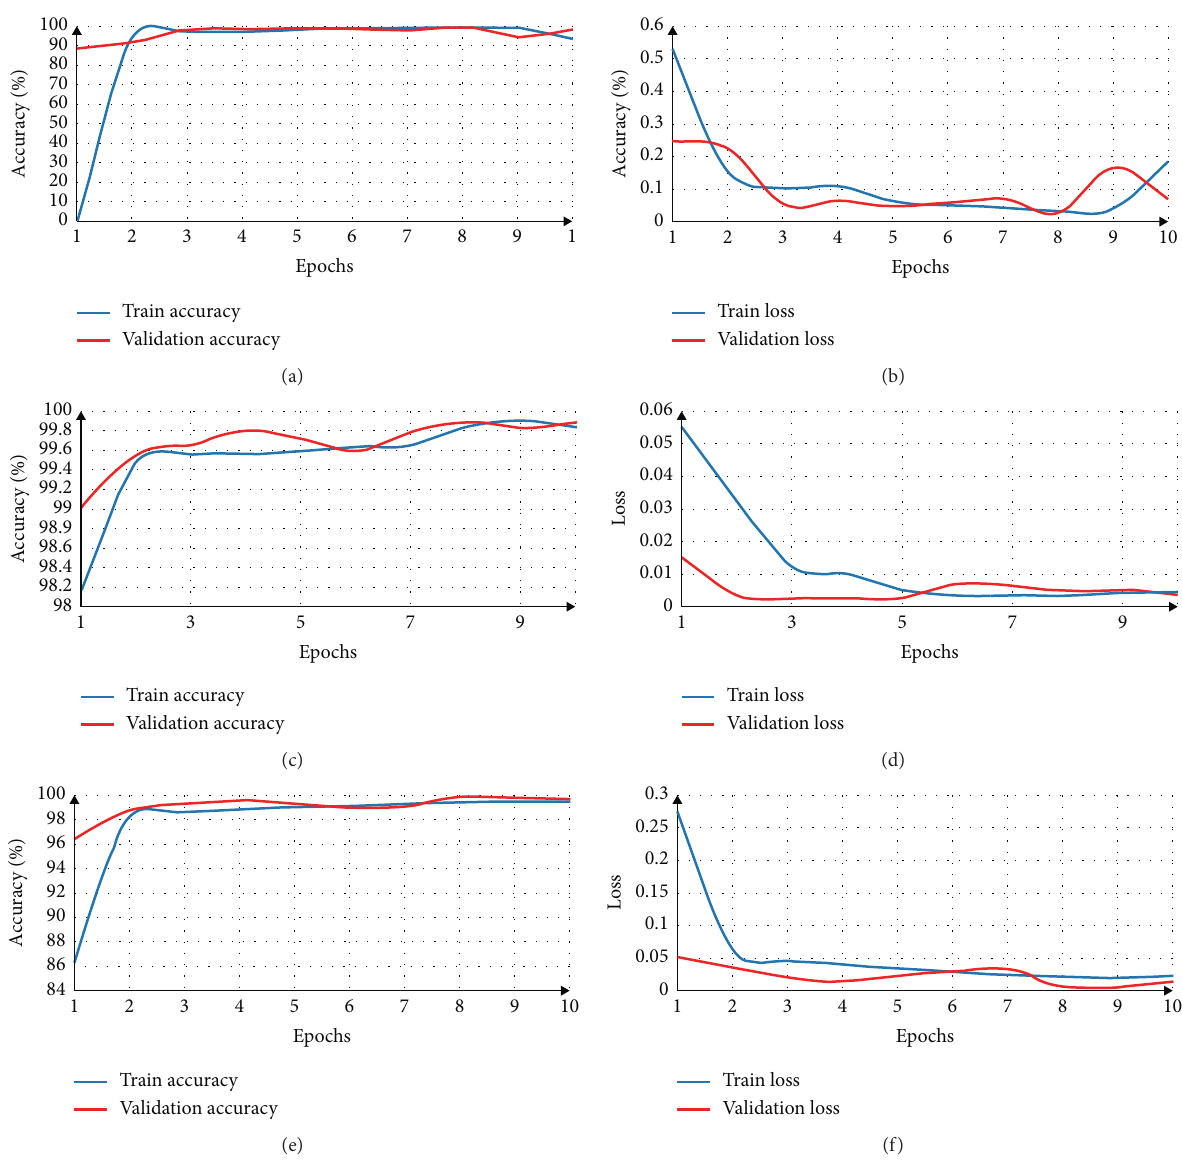
Figure 5: Accuracy and loss values of the three models: (a) Model1 accuracy; (b) Model1 loss; (c) Model2 accuracy; (d) Model2 loss; (e) Model3 accuracy; (f) Model3 loss. Table 4: The performance of models for 10 epochs.